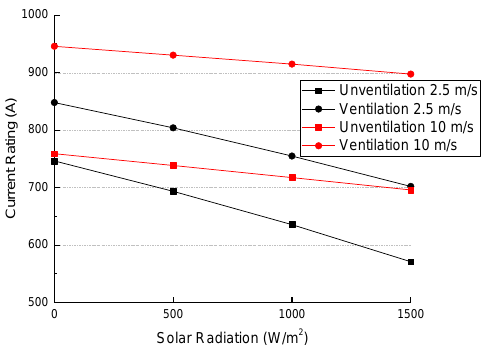
Figure 10. Ratings for different intensities of solar radiation.